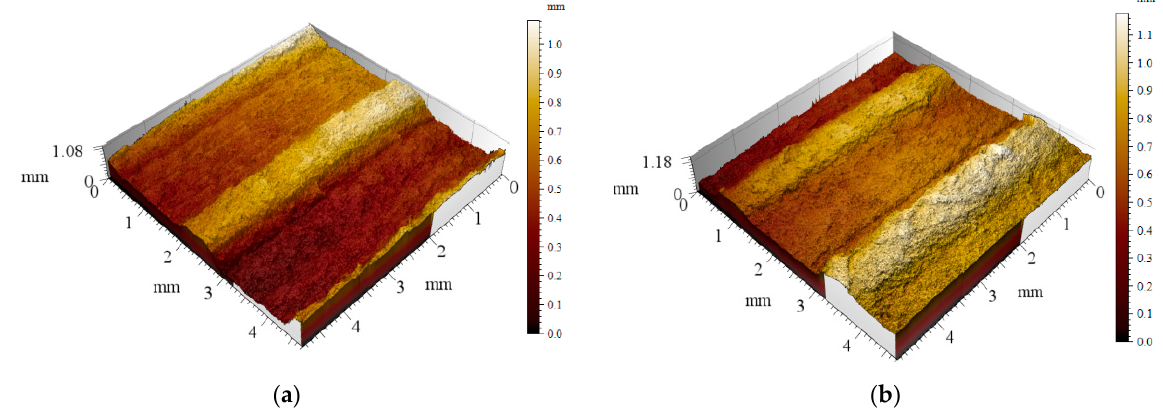
Figure 3. Three-dimensional dry pasta surface of ( a ) control and ( b ) optimal sample with grape peels (OGP).